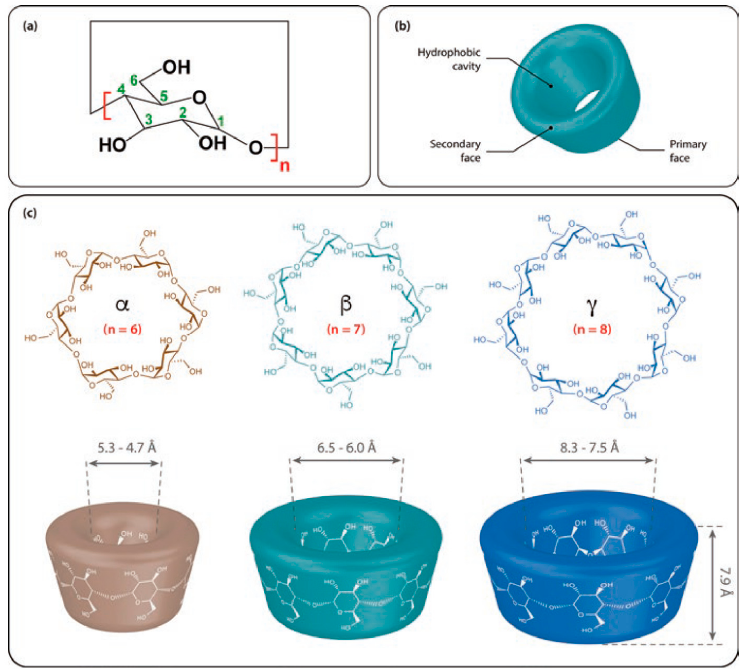
Figure 1 . Cyclodextrin (CD) structures of ( a ) the monomer unit, ( b ) the overall shape, and ( c ) the structures of α -, β -, and γ -CDs. Reprinted with permission from Springer Nature: Springer International Publishing AG, Cyclodextrin Fundamentals, Reactivity and Analysis by Crini et al., Reference [3], COPYRIGHT